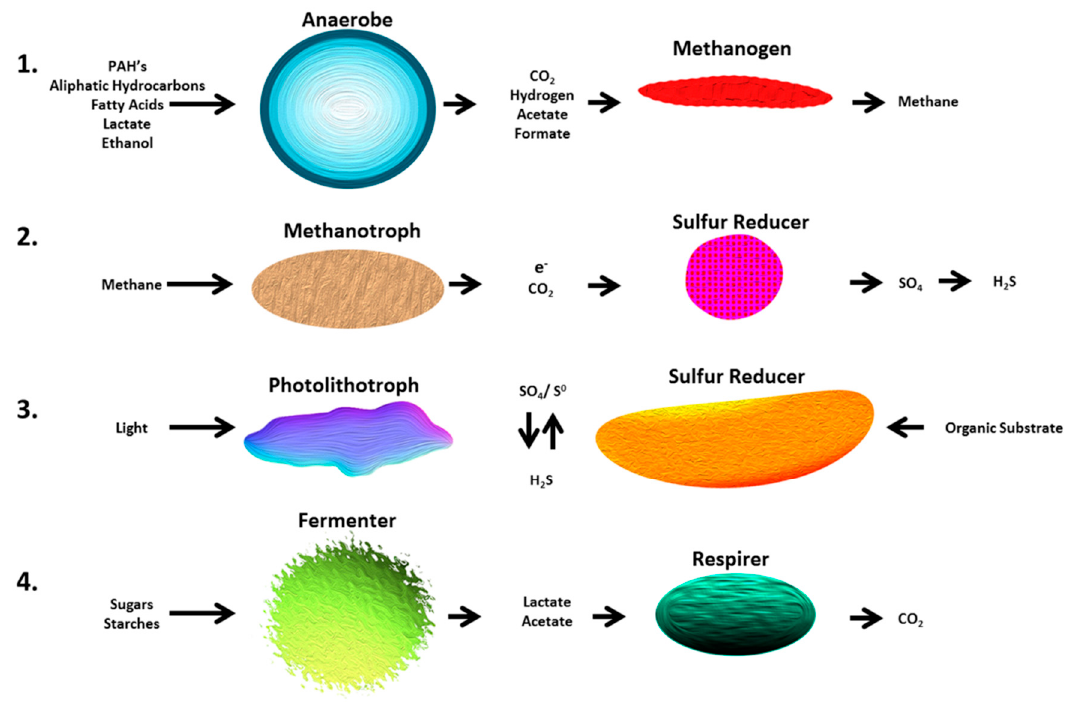
Figure 2. Syntrophic interactions: by-products from one type of microorganism aid in the growth and proliferation of another (adapted from Wintermute & Silver, 2010, permission has been given by CSHL Press). PAH: polyaromatic hydrocarbon.